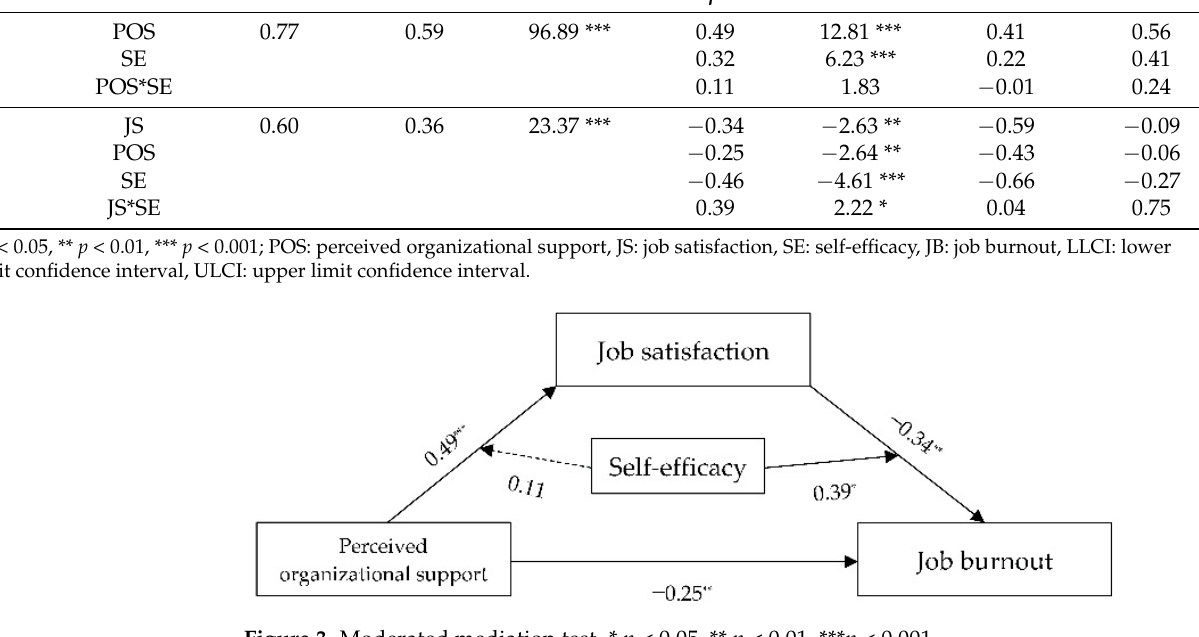
on the correlation between JS and JB. With the increase in SE, the predictive effect of JS on JB gradually declined (from [effect = − 0.56, t = − 3.16, p < 0.01, 95% CI = − 0.91; − 0.21] to [effect = − 0.12, t = − 0.82, p > 0.05, 95% CI = − 0.41; 0.17]). As shown in Figure 4, the conditional indirect effect of POS on JB through JS was statistically significant at the value of one standard deviation lower than the mean of self- efficacy (effect = − 0.24, SE = 0.09, 95% CI = − 0.43; − 0.08). However, this indirect effect was not significant at the value of one standard deviation above the mean of the moderator (effect = − 0.07, SE = 0.13, 95% CI = − 0.33; 0.16). With an increase in the editors’ sense of SE, the indirect effect of POS on JB via JS was gradually weakened. In sum, the moderated mediation model was partly established. JS acted as a media- tor in the link between POS and JB. Moreover, SE served as a moderator in the association between JS and JB but did not play a moderating role in the relationship between POS and JS.